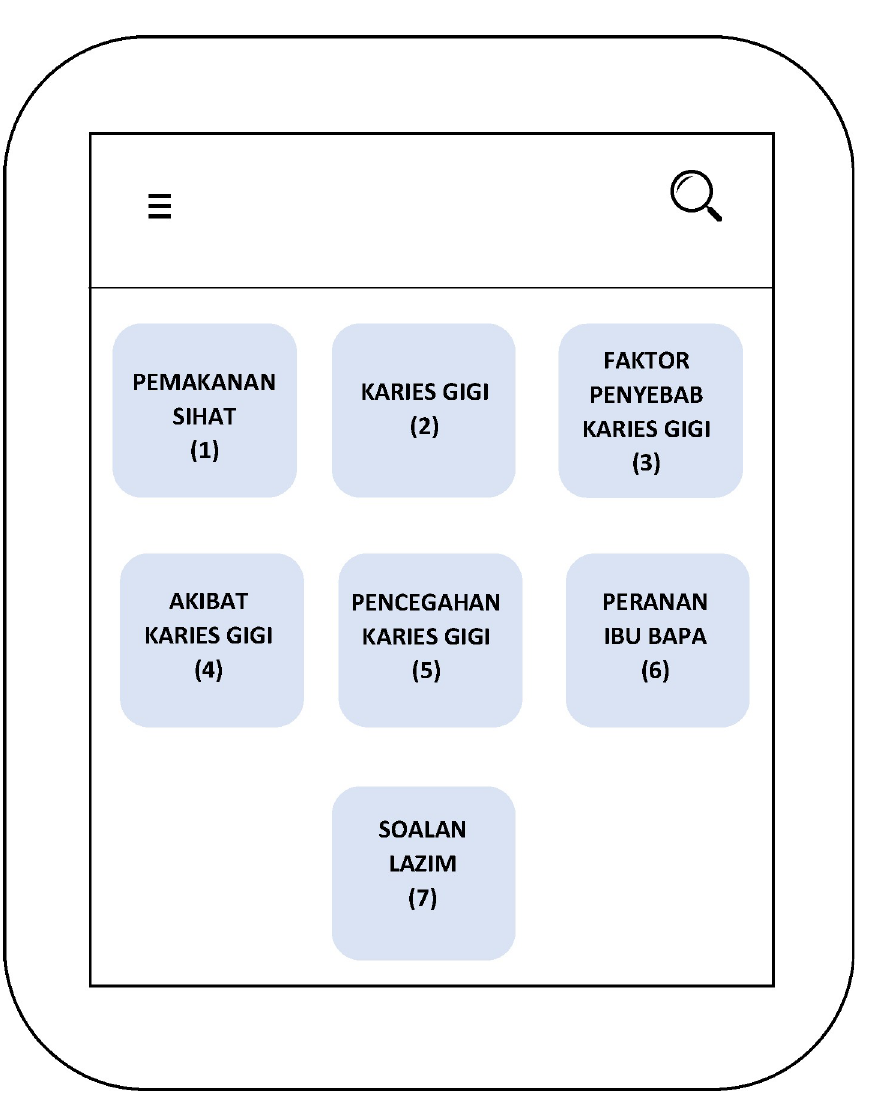
Fig 2. Microsoft words computer printed